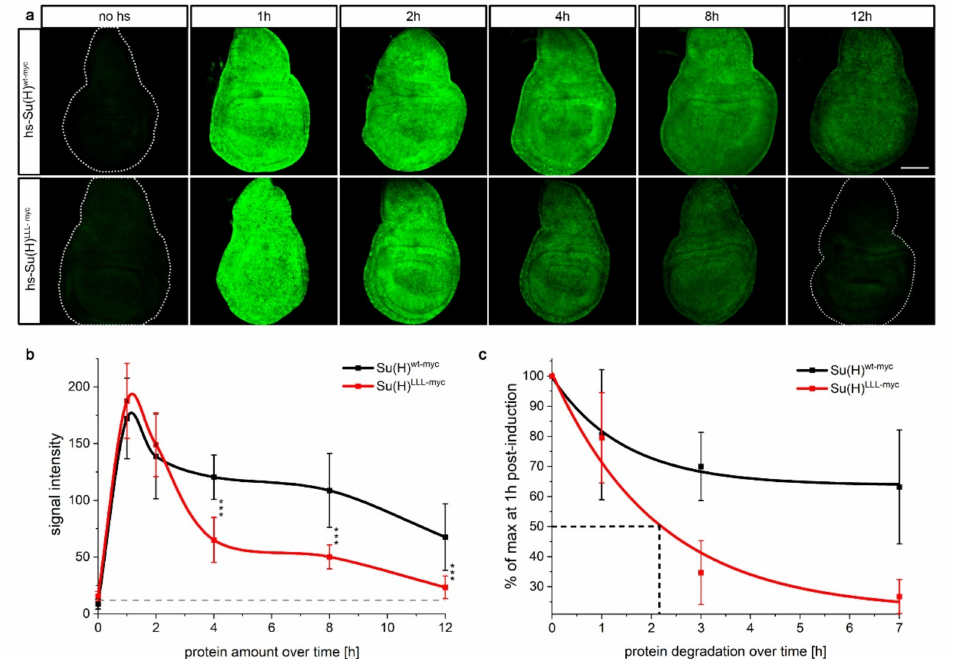
Figure 1. In vivo stability of Su(H) protein in imaginal tissue. ( a ) Su(H) wt-myc and Su(H) LLL-myc protein expression, respectively, induced by a 30 min heat pulse, and monitored via the myc tag in wing imaginal discs at specific time points after heat shock as indicated. Typical examples are shown. Size bar, 100 µ m in all panels. ( b ) Quantification of Su(H) wt-myc and Su(H) LLL-myc protein amounts. Signal intensity was recorded, and data sampled from ten independent experiments each performed in parallel under identical conditions. SD is indicated. The grey dashed line denotes the baseline, i.e., signal intensity without heat shock. Note similarity in induction, followed by a rapid drop at 2 h for both protein variants. Whereas Su(H) LLL-myc protein amounts sink rapidly and significantly, Su(H) wt-myc levels are stabilised at about 67% of the maximum induction. *** p < 0.001. ( c ) Drop of protein levels over time; peak expression at 1 h after heat shock induction was taken as 100%. Note stabilisation of Su(H) wt-myc at about 67% max. Half-life of Su(H) LLL-myc is at around 2